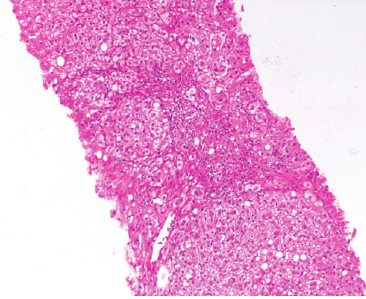
Figure 1. Liver biopsy showed expanded portal tracts with lymphocytic infiltrates and fibrosis, occasional plasma cells are also noted with foci of piecemeal necrosis and lobulitis also visualize with bridging fibrosis.